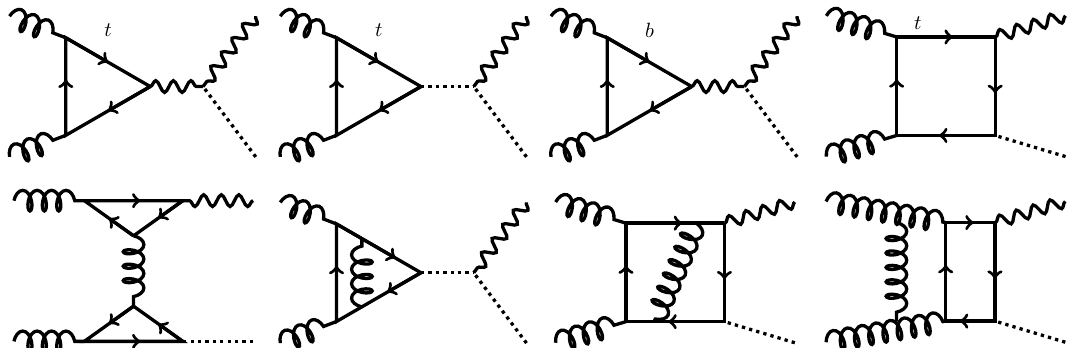
Figure 1. LO and NLO Feynman diagrams contributiong to gg → ZH . Curly, wavy and dashed lines represent gluons, Z bosons and scalar particles (Higgs or Goldstone bosons), respectively. Solid lines stand for top or bottom quarks. Note that the latter are only present in the triangle